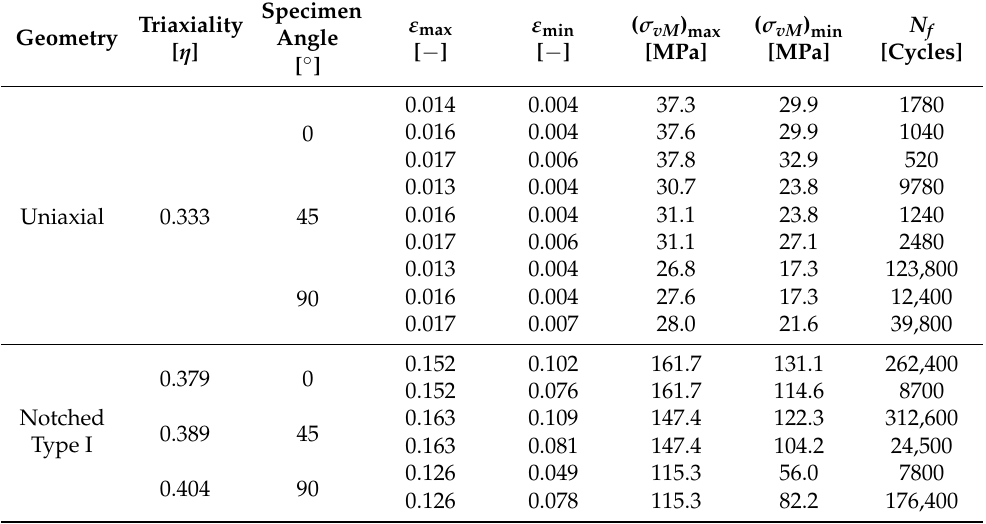
Table 5. Summary of fatigue experiments on the uniaxial, notched, and complex specimens of